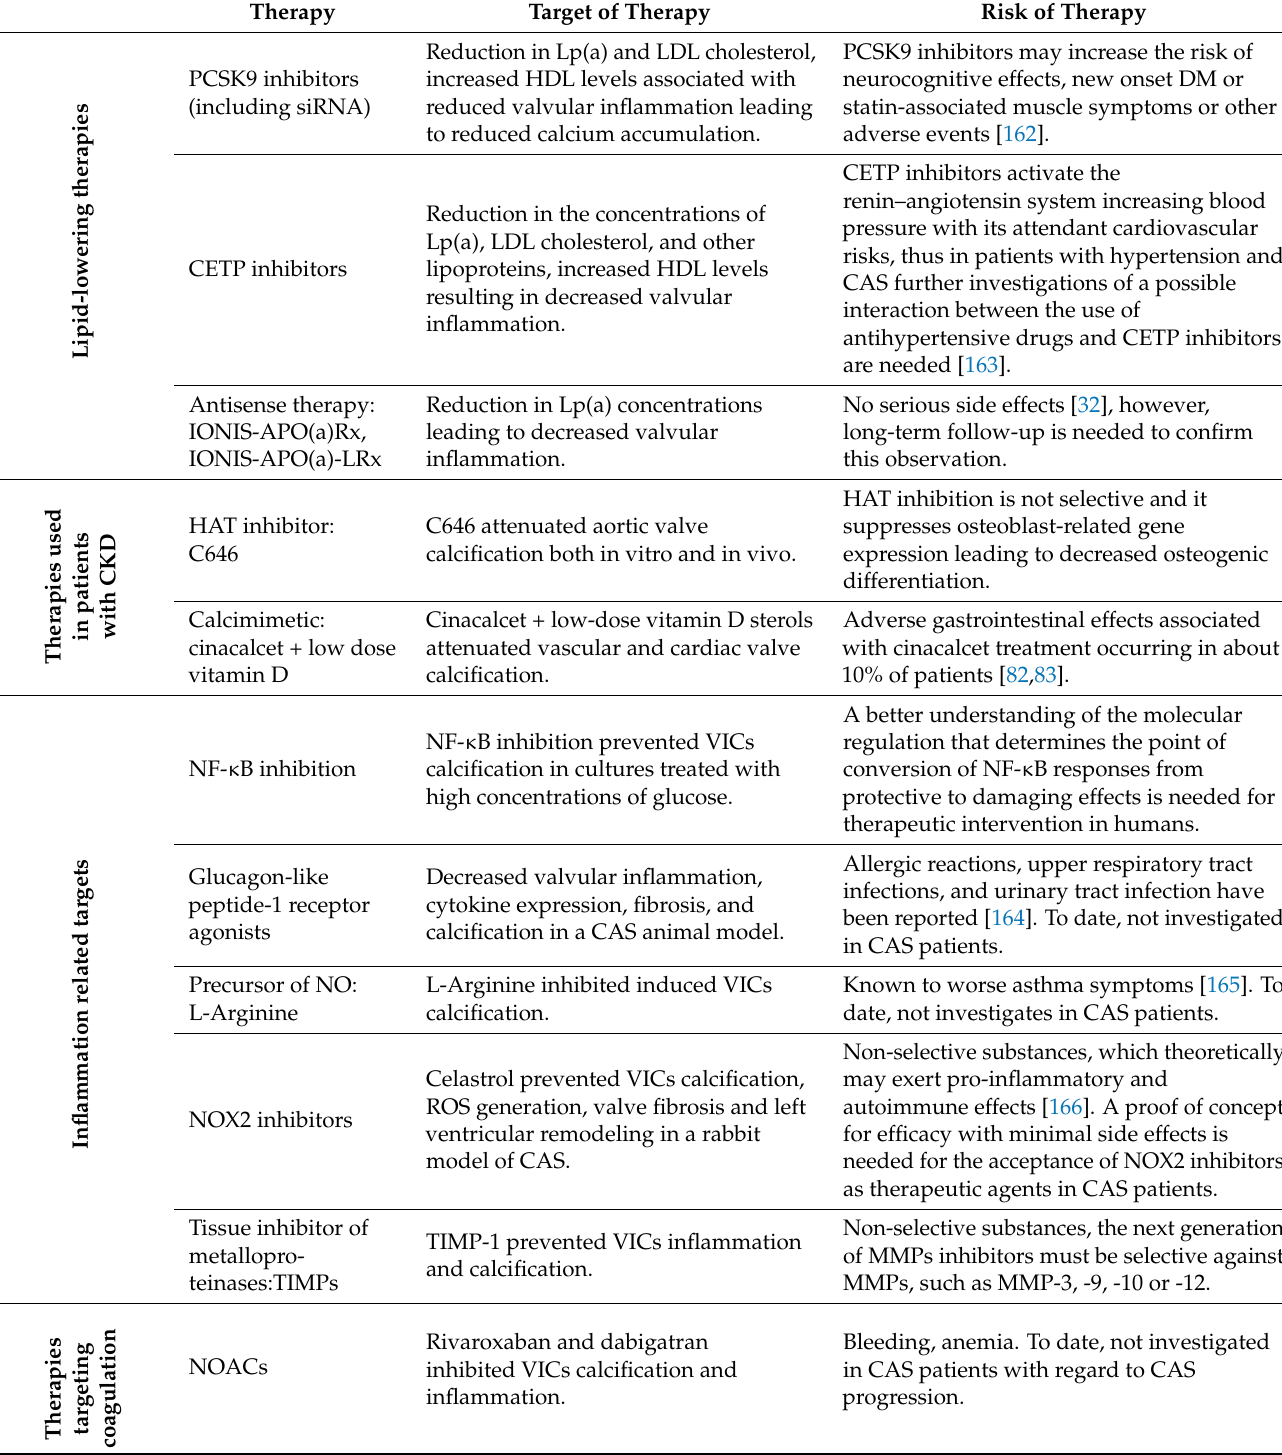
Table 2. The most promising future perspectives regarding treatment of aortic